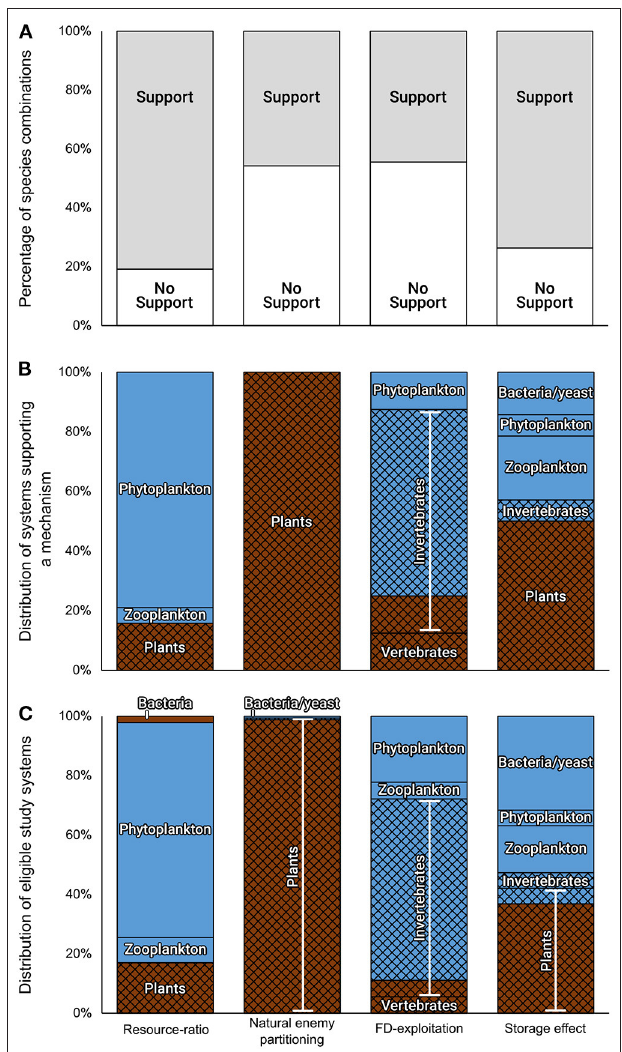
FIGURE 5 | Assessment of the prevalence of the four chosen coexistence mechanisms, illustrating the deficiencies in our current mechanistic knowledge. The experimental support varied among mechanisms, suggesting that their prevalence in nature is different (A) . The division of the species combinations that were tested in the eligible studies and support a mechanism, according to the taxonomical groups of the interacting species (white titles), origin (aquatic in blue and terrestrial in brown), and size (microbes on a plain colored background and macroorganisms on a hatched background), demonstrates a link between the coexistence mechanism and the study system (B) . However, since the division of supporting evidence among organismal groups was similar to their division among all eligible tested species combinations (C) , it was not clear whether these results reflect a tendency of specific groups to be controlled by particular coexistence mechanisms or a bias already introduced during the stage of model-system choice. Taken together, these results suggest that the scarcity of eligible tests and the bias of specific mechanisms toward specific study systems do not permit a comprehensive analysis of the prevalence of the four chosen coexistence mechanisms in